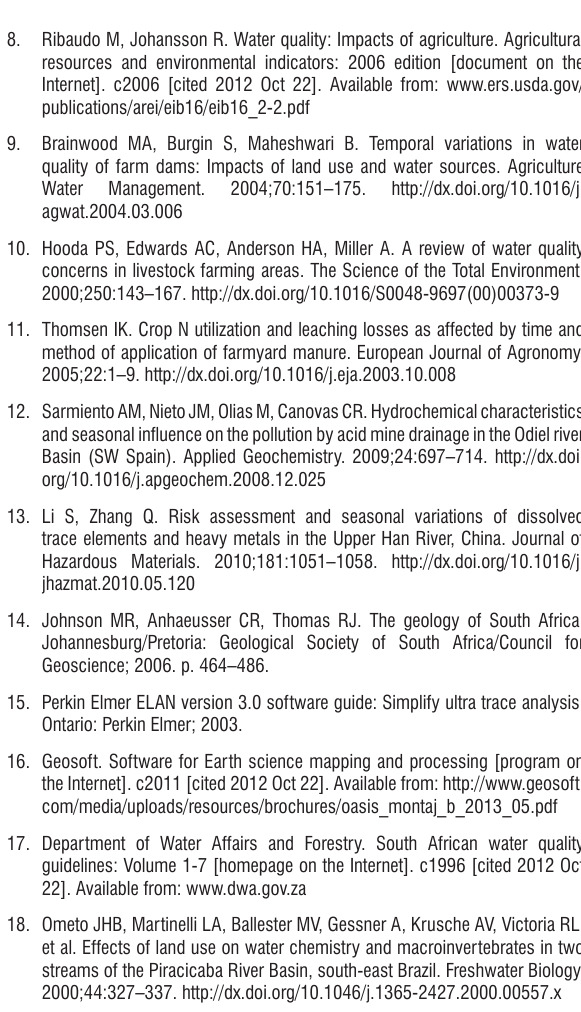
Season Variable Concentration